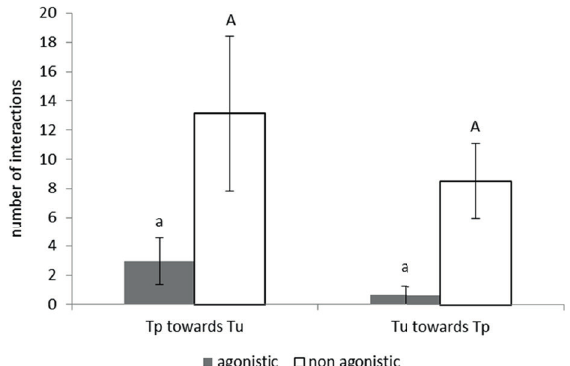
Figure 2 - Mean agonistic and non-agonistic encounters per trial between Telenomus podisi (Tp) and Trissolcus urichi (Tu) when searching simultaneously for Piezodorus guildinii egg masses. Diff erent letters indicate signifi cant diff erences in the number of agonistic (small letters) or non-agonistic (capital letters) encounters between wasps. Bars denote 95% confi dence